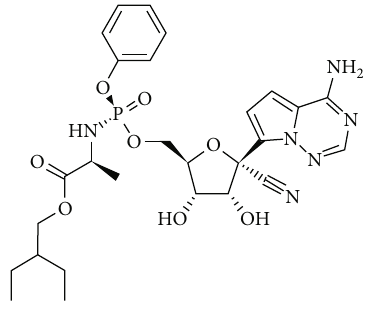
Figure 2: Molecular graph of remdesivir (GS-5734). Table 1: Edge partitioning based on degree of remdesivir